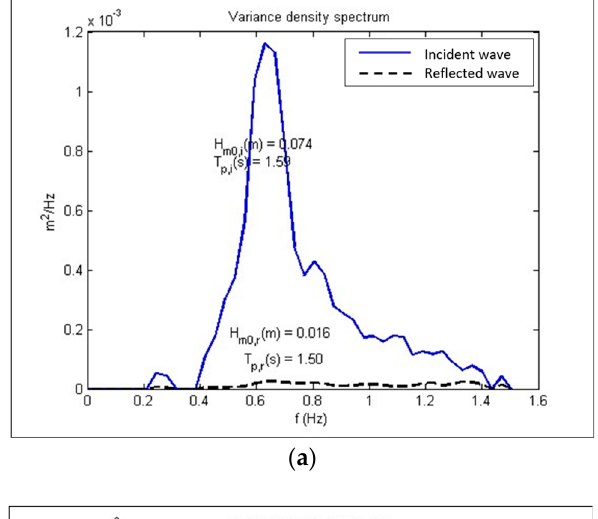
18 of 22 Figure 13. Wave transmission coefficients versus relative crest freeboards of different types of break- waters: PRBW (Le Xuan Tu et al., 2020) [10], HTB (Le Xuan Tu et al., 2022) [11], rubble-mound BW